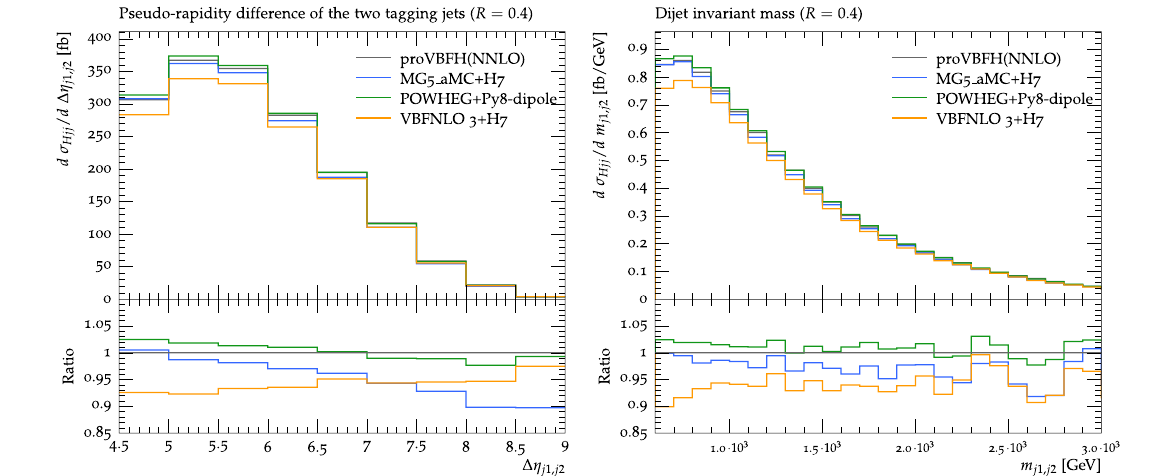
Fig. 11 Separation in pseudo-rapidity (left) and invariant-mass distribution of the two tagging jets (right) within the cuts of Eqs. (3)–(4) at NLO + PS accuracy for the MadGraph5_aMC- @NLO , POWHEG-BOX , and VBFNLO + Herwig7/Matchbox gener-